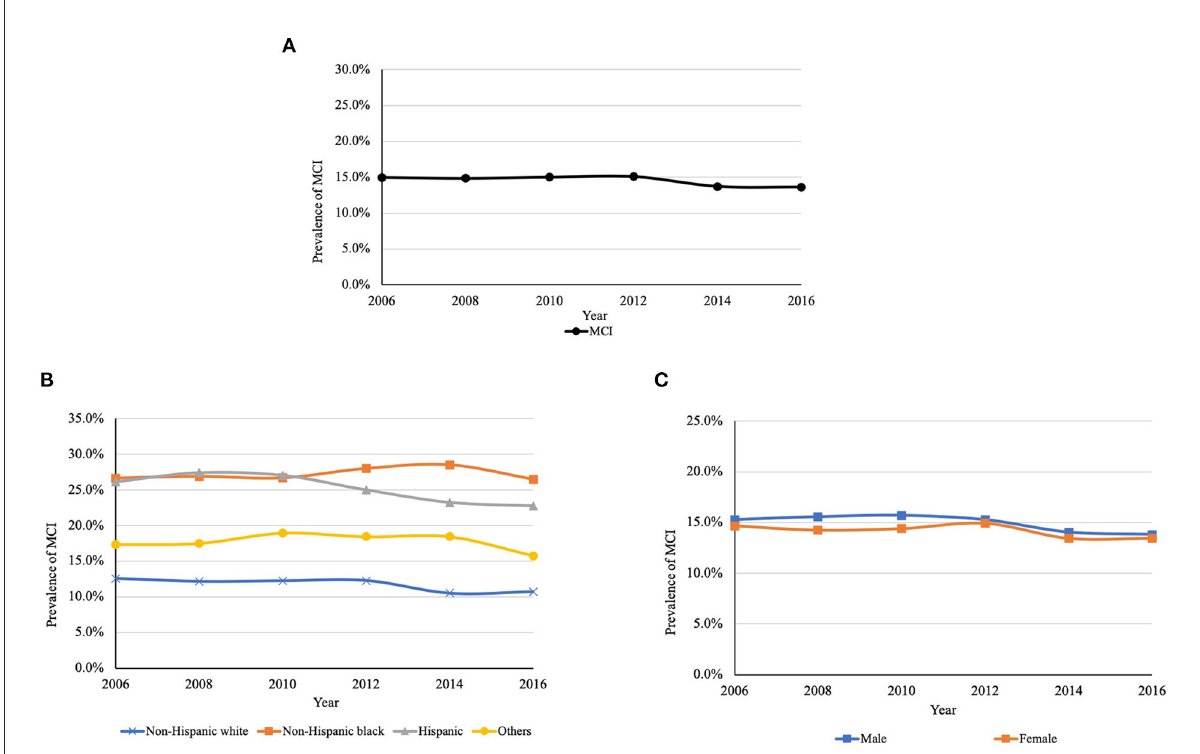
FIGURE2 (A) Trends in the prevalence of MCI between 2006 and 2016. (B) Trends in the prevalence of MCI between 2006 and 2016 by race/ethnicity a . (C) Trends in the prevalence of MCI between 2006 and 2016 by gender b . MCI, mild cognitive impairment. a P < 0.001; b P = 0.448. P -values are for the type 3 test for the difference in the prevalence among race and